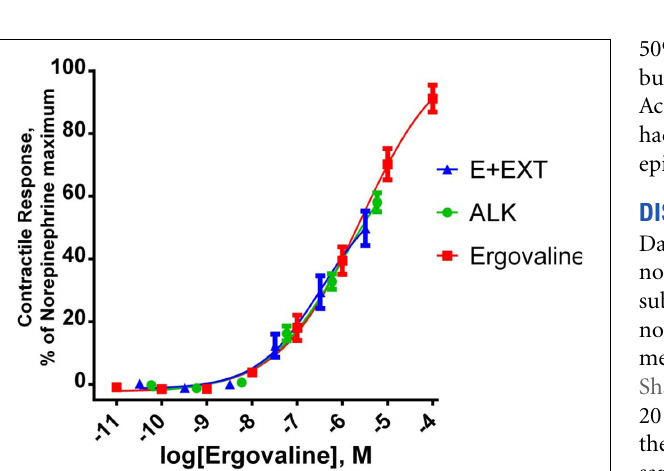
FIGURE 4 | Fragment ion spectrum of m/z 534 fragment of chemical standard ergovaline and the partially purified extract from panel 3D. (A) is chemical standard for ergovaline, (B) is the ergovaline extract.